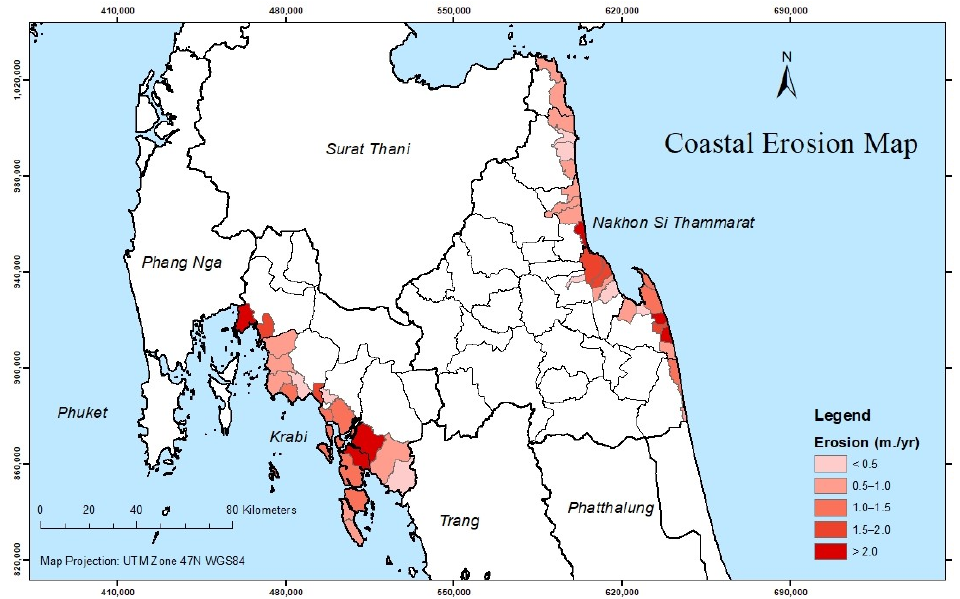
Figure 2. Coastal erosion rate along the Krabi and Nakhon Si Thammarat coasts, Thailand. Table 1. Total participants by